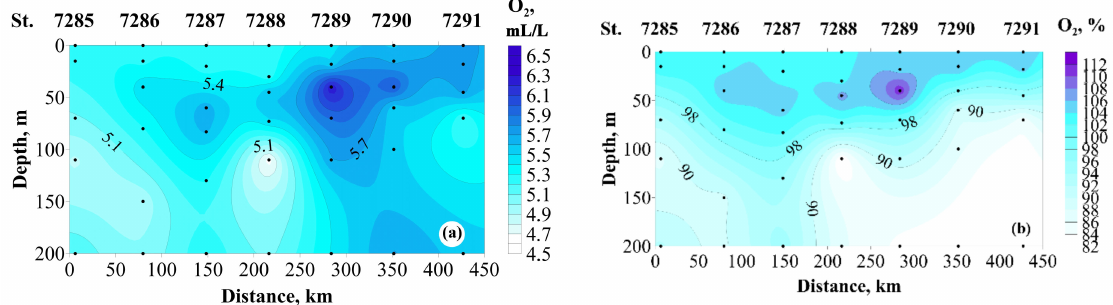
Figure 6. Concentration of dissolved oxygen (O 2 , mL/L) ( a ) and degree of oxygen saturation ( b ) over the section.